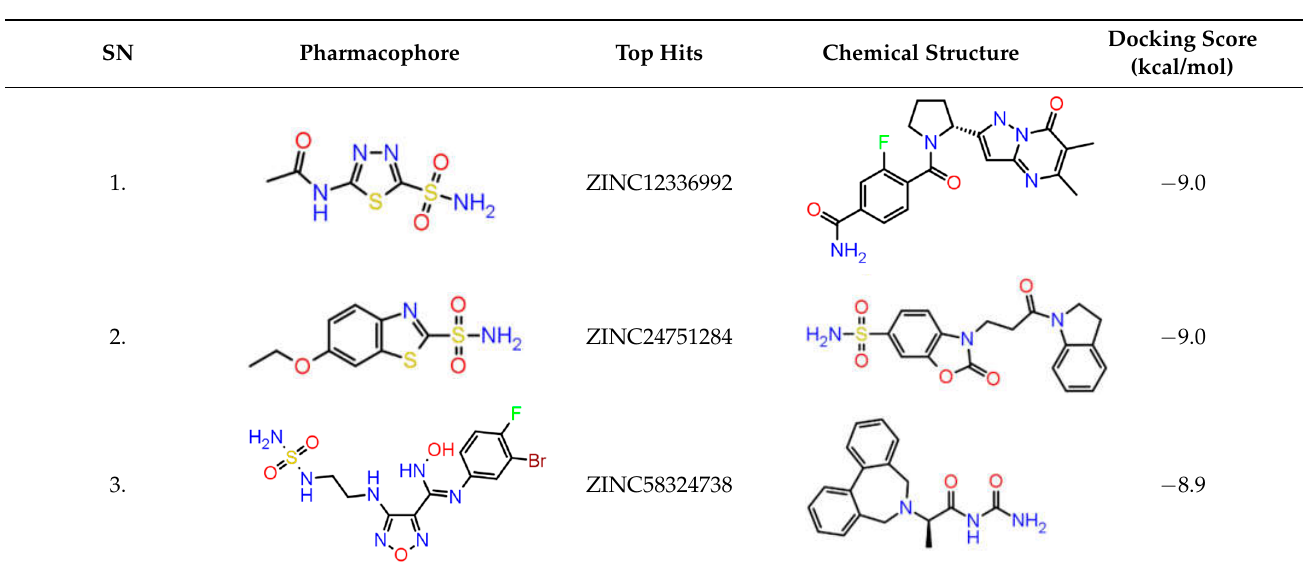
Table 1. Top three hits obtained after virtual screening of the ZINC database.